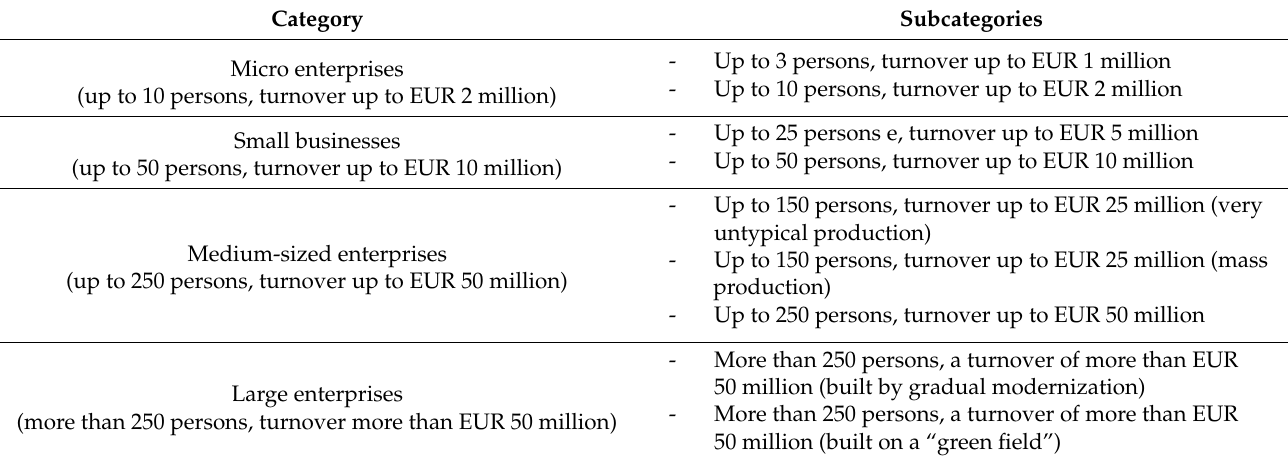
Table 1. Categories and subcategories affecting technology